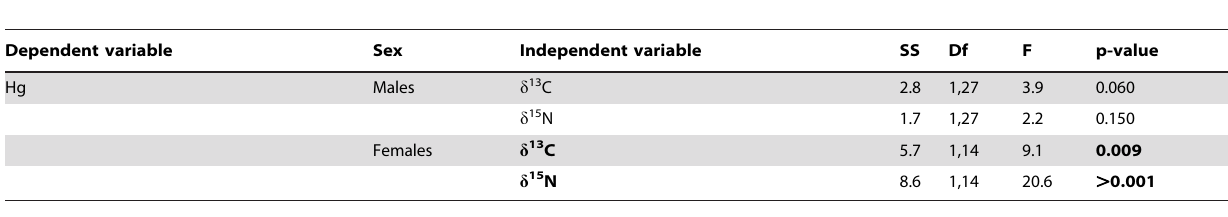
Table 3. Modelling the relationships between blood d 13 C, d 15 N values ( % ) and blood Hg concentration ( m g ? g 2 1 dw) in male and female pre-laying snow